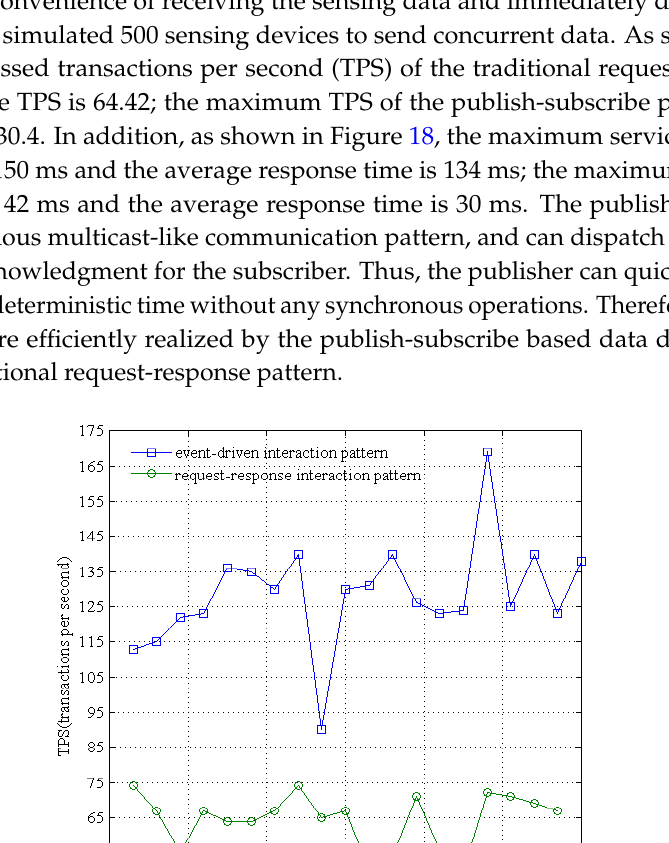
Figure 17. Transactions processed per second of event-driven and request-response.